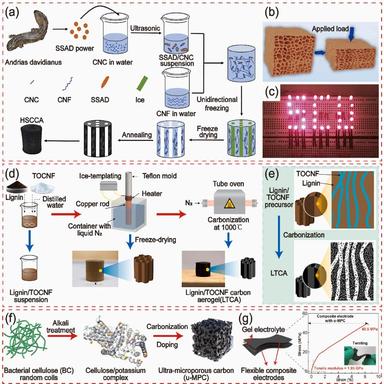
(a) Schematic of the preparation process for HSCCA. (b) Compression model of HSCCA. (c) Schematic for the assembling of three SCs in series and photographs showing 31 LEDs powered by the HSCCA SCs in series. (d) LTCAs production process and illustrations of the products generated from each step. (e) Schematic of the expected microstructure of the lignin/2,2,6,6-tetramethylpiperidin-1-oxo (TEMPO)-cellulose nanofiber (TOCNF) aerogel before and after carbonization. (f) Schematic illustration for the fabricatio